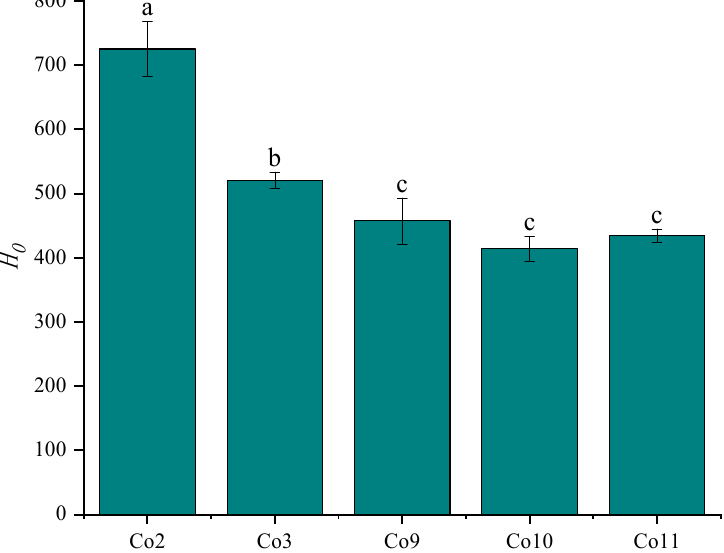
Figure 4. Surface hydrophobicity of Co prepared under different extraction pH conditions. Note: Different letters indicate that there is a significant difference between samples ( p < 0.05).